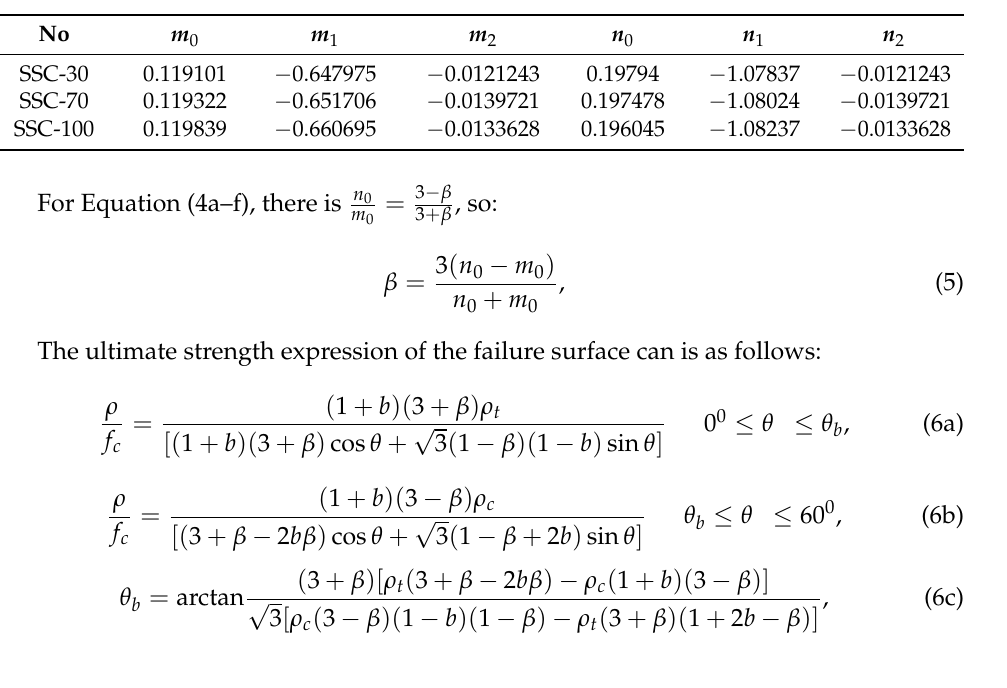
Table 4. Values of m and n for SSC under triaxial